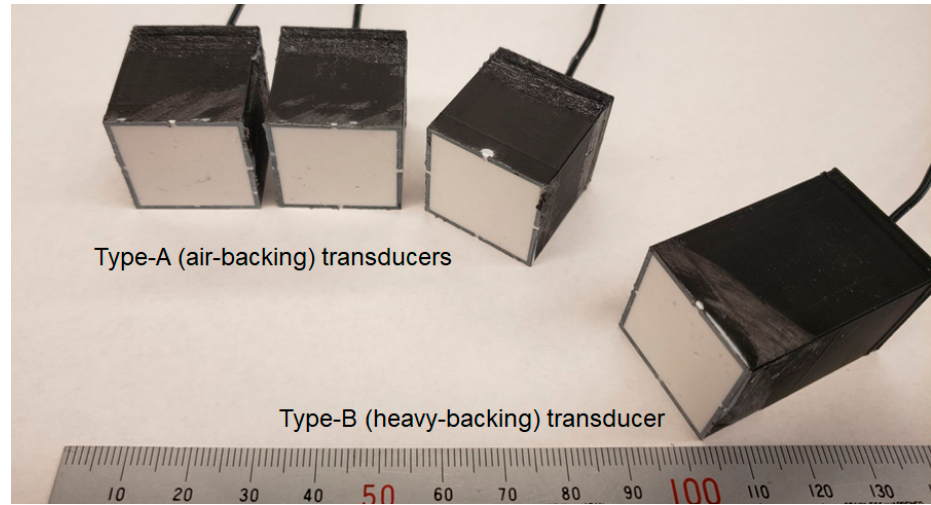
Figure 4. Photo of prototype transducers: type A (air-backing) transducers and a type B (heavy- backing) transducer.